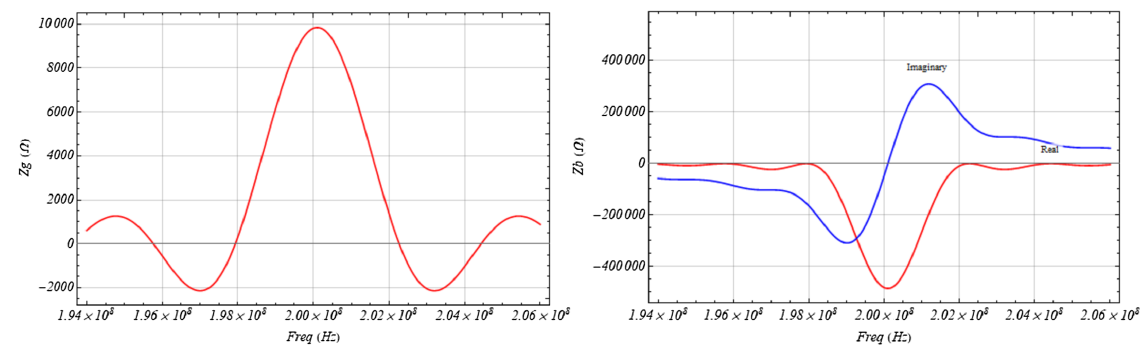
f Þ after compensation of the τ = 2 delay. Right: real (red) and imaginary parts of Z g ð